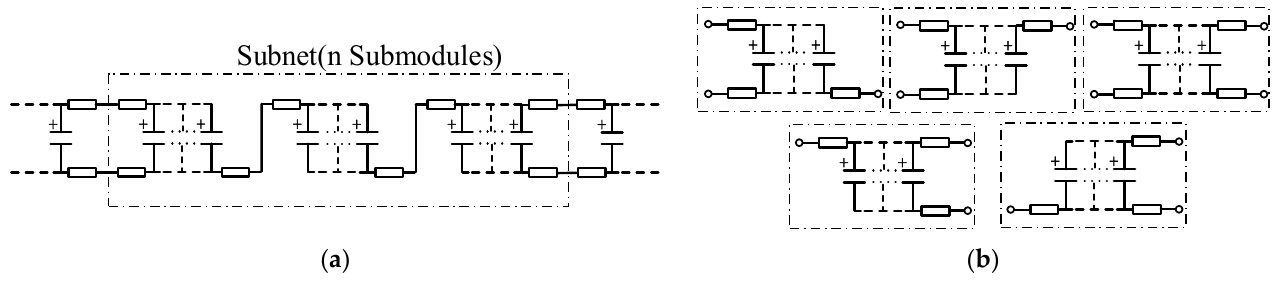
Figure 8. Subnetwork divided by a fixed number of submodules: ( a ) connection of submodules in the subnetwork; ( b ) added submodule parallel combination forms.